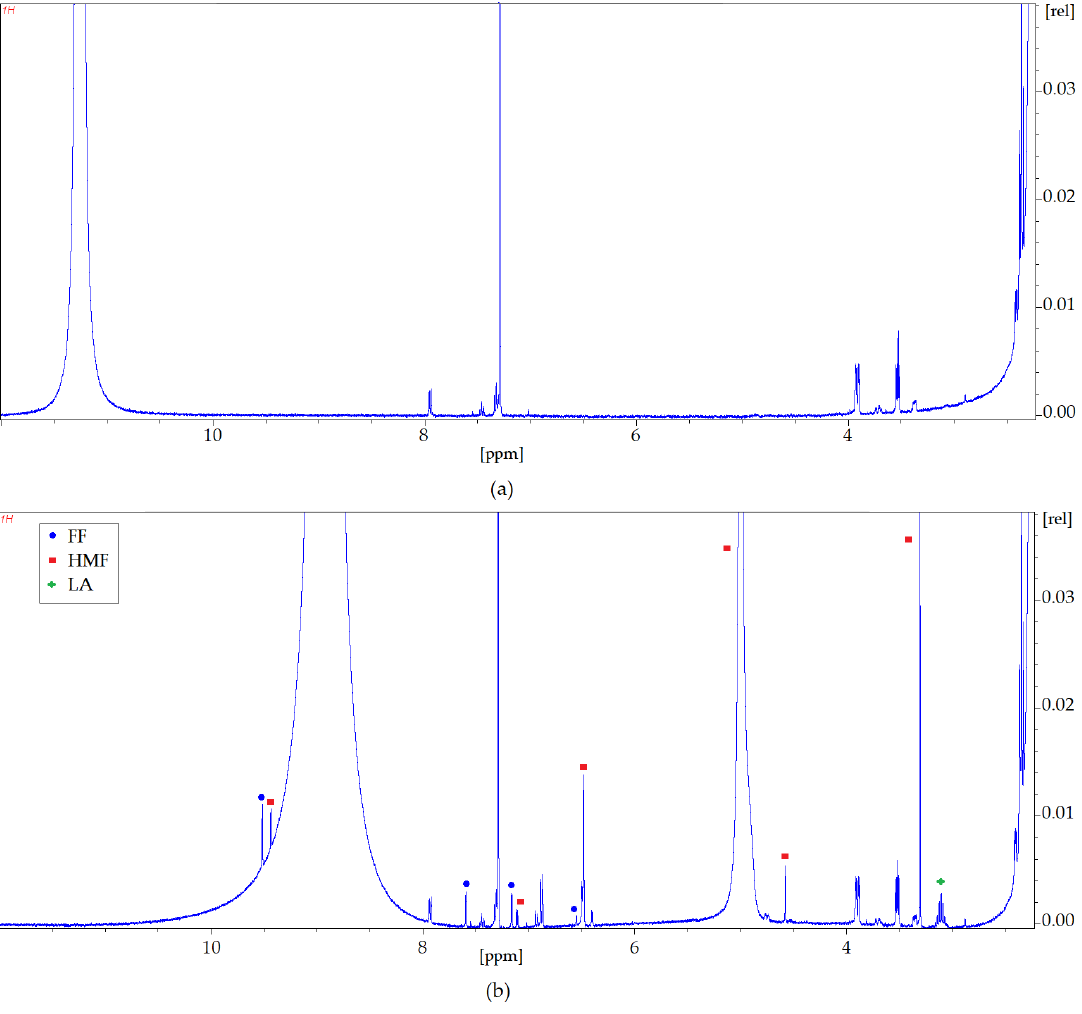
Figure 10. 1 H NMR spectra zoom ( a ) before the extraction process; ( b ) after the extraction process for Cam: OA (1:1).